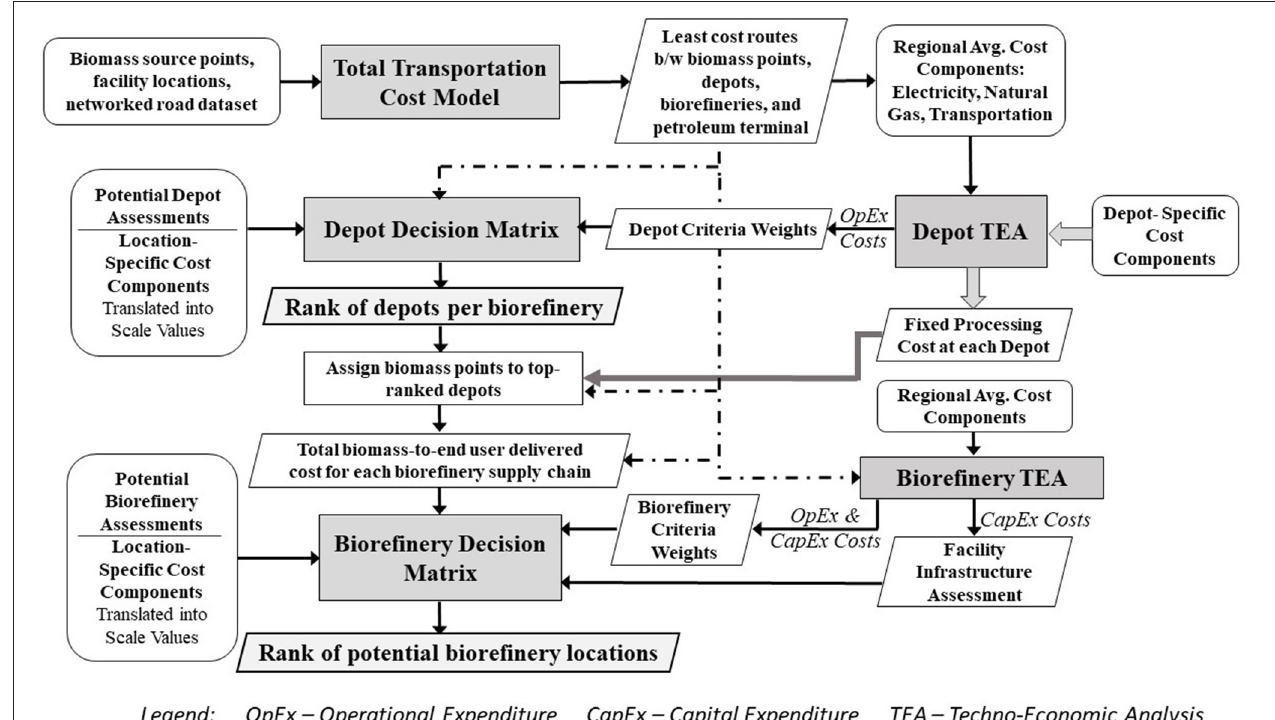
FIGURE 1 | Process flow diagram for depot-and-biorefinery facility siting model.